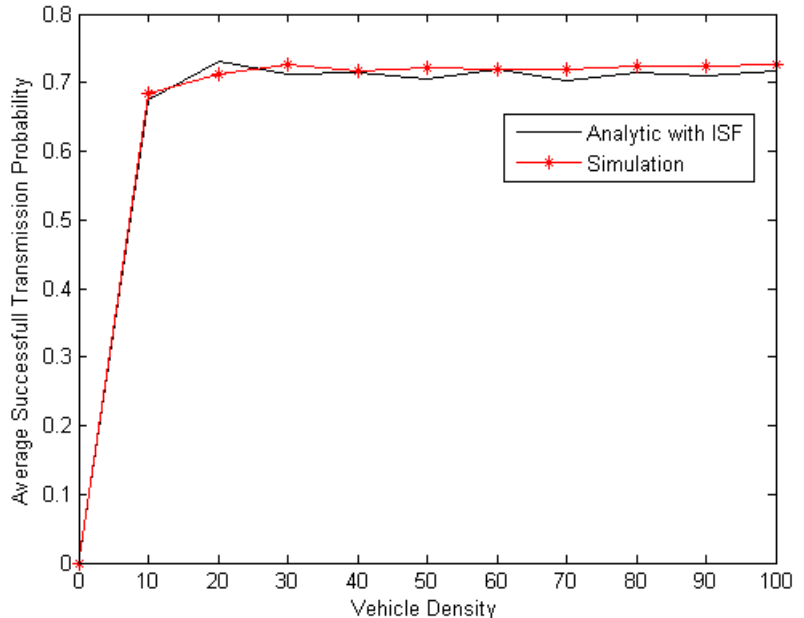
Figure 12. Comparison between the simulation and the analytical results of the average successful transmission probability of the CSSA MAC protocol.